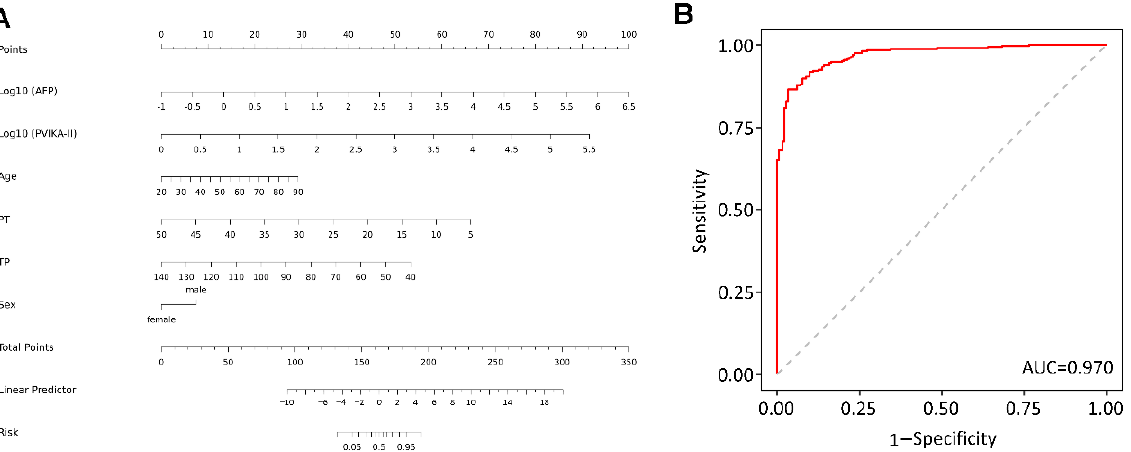
Figure 2. Diagnostic nomogram for patients with HCC. ( A ) A diagnostic nomogram for differentiating HCC cases from chronic HBV and LC. ( B ) AUROC for the diagnostic nomogram in differentiating HCC cases from chronic HBV and LC.